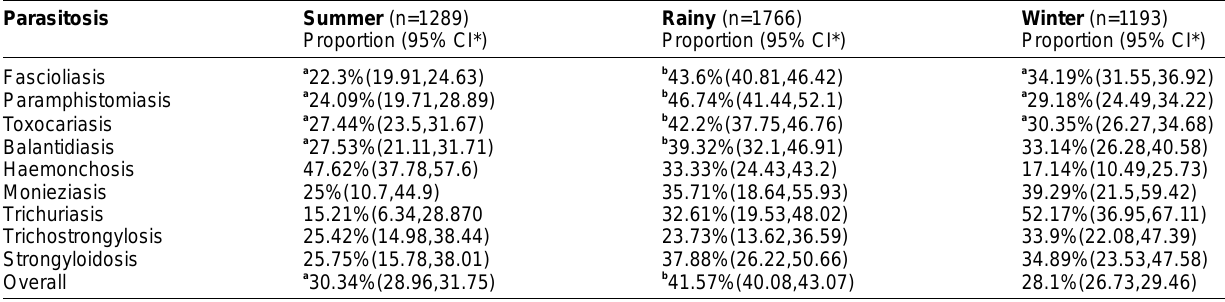
Table-2. Seasonal distribution of different gastrointestinal parasitism in cattle in Sirajganj